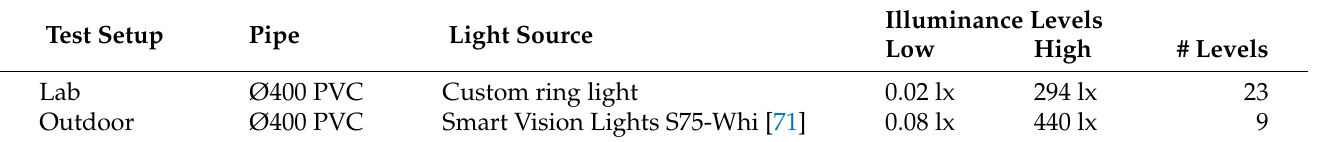
Figure 7. Outdoor above-ground experimental setup. The four wells are laid out in a square configuration with 5m between each corner. Table 3. Configuration of the experimental setups for the illumination